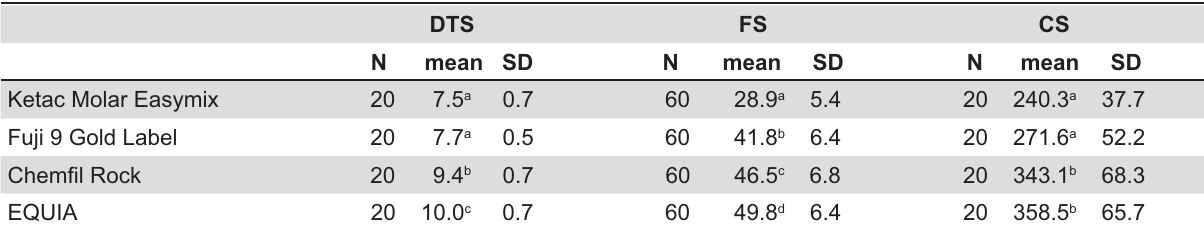
Table 1- (cid:9)*(cid:6)(cid:14)(cid:25)(cid:9)(cid:14)(cid:25)(cid:5)(cid:9)(cid:18)(cid:21)(cid:14)(cid:25)(cid:5)(cid:14)(cid:7)(cid:5)(cid:9)(cid:5)(cid:6);(cid:19)(cid:14)(cid:21)(cid:19)(cid:3)(cid:25)(cid:9)<=>?(cid:9)(cid:18)(cid:20)(cid:3)(cid:7)(cid:6)(cid:18)(cid:9)(cid:19)(cid:25)(cid:9)*(cid:2)(cid:14)(cid:9)V(cid:3)(cid:7)(cid:9)(cid:5)(cid:19)(cid:14)(cid:26)(cid:6)(cid:21)(cid:7)(cid:14)(cid:11)(cid:9)(cid:21)(cid:6)(cid:25)(cid:18)(cid:19)(cid:11)(cid:6)(cid:9)(cid:18)(cid:21)(cid:7)(cid:6)(cid:25)(cid:22)(cid:21)$(cid:9)<>W=?(cid:23)(cid:9)(cid:16)(cid:6)"(cid:17)(cid:7)(cid:14)(cid:11)(cid:9)(cid:18)(cid:21)(cid:7)(cid:6)(cid:25)(cid:22)(cid:21)$(cid:9)<(cid:28)=?(cid:9)(cid:14)(cid:25)(cid:5)(cid:9) in Newton for compressive strength (CS) by the four brands of glass-ionomers